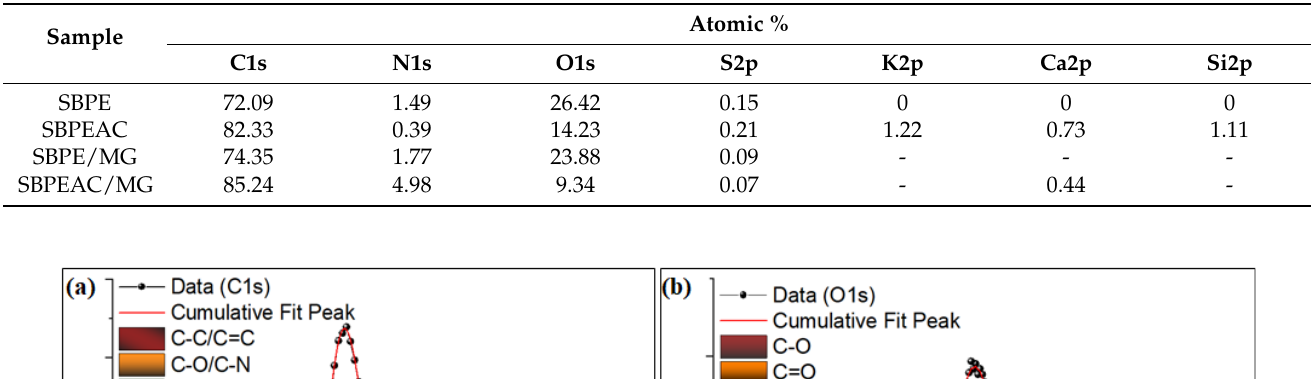
Table 1. Element contents of the pristine and MG-loaded adsorbent samples determined by XPS analysis.